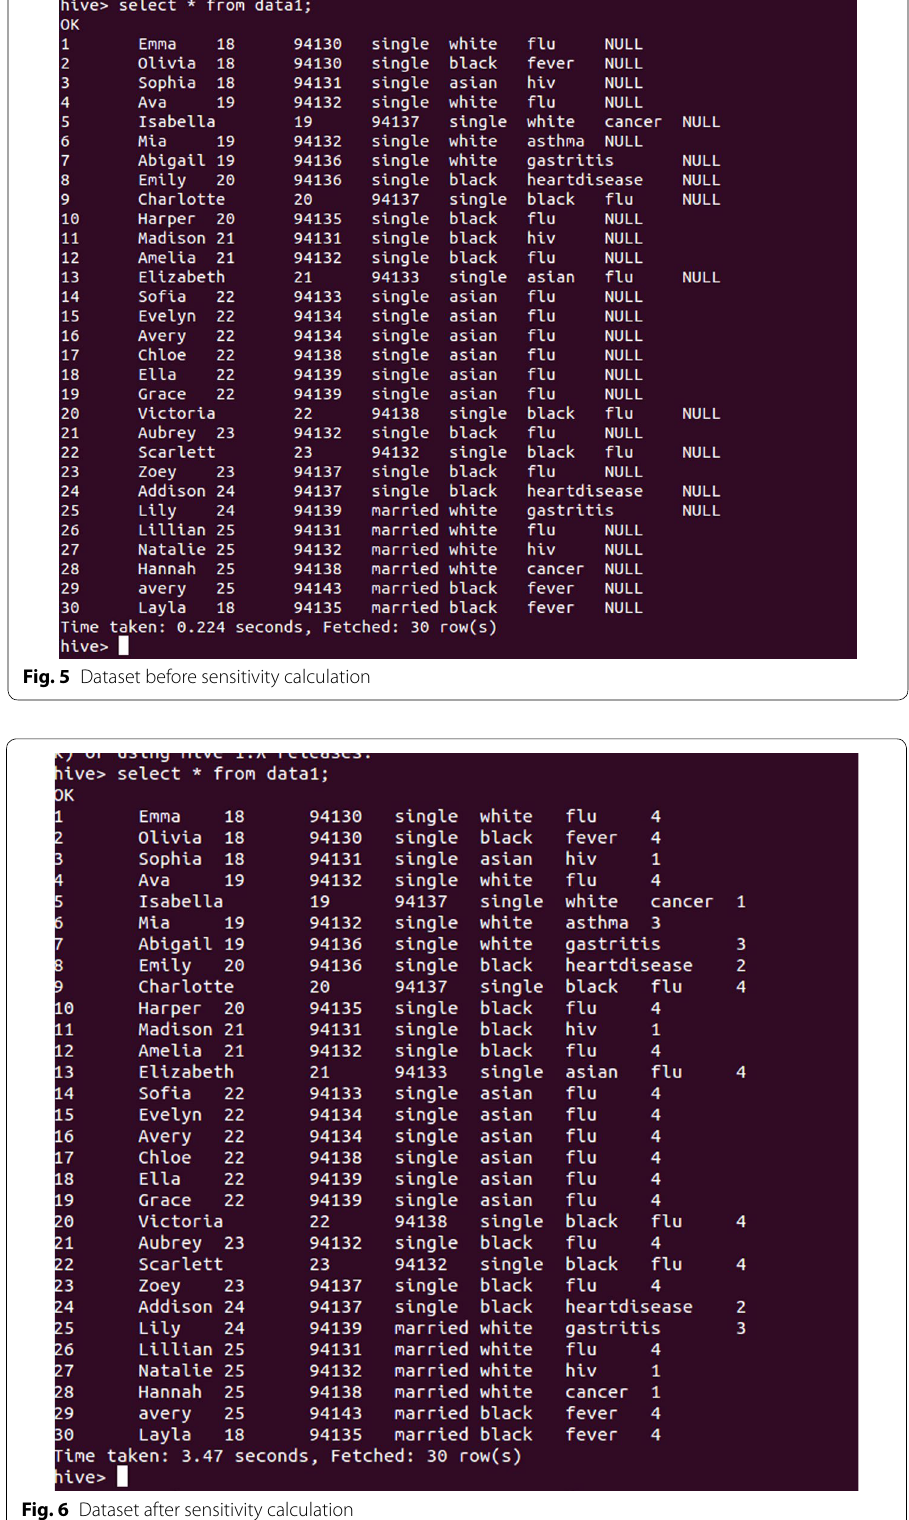
Fig. 6 Dataset after sensitivity